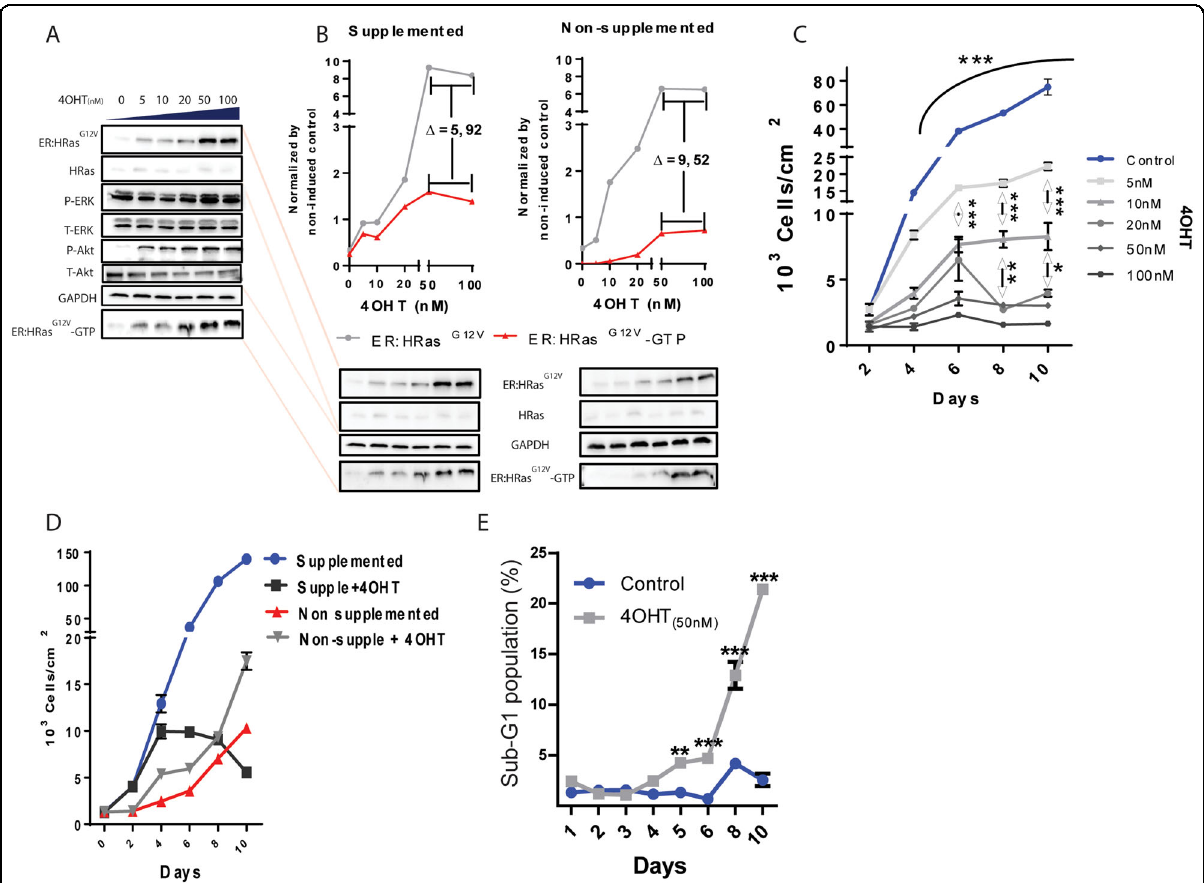
Fig. 1 High HRas G12V activity causes oncogenic stress in the E6E7 keratinocytes grown in supplemented media. A Immunoblots: 4OHT dose – response of ER:HRas G12V induction. The activity of HRas G12V was monitored by a RAS-GTP-binding assay, which leads to downstream activation of P-ERK and P-Akt. B Immunoblots comparing ER:HRas G12V levels between supplemented (5 ng/mL of EGF and 5 µL/mL of pituitary extract) and nonsupplemented media in ER:HRas G12V -keratinocyte cultures. The immunoblot of cells in the supplemented medium is a projection of the one presented in A . The electrophoresis gel of cell lysates derived from cells grown in either supplemented or nonsupplemented media, was blotted in the same membrane to allow comparison of ER:HRas G12V levels and HRas G12V -GTP (HRas G12V -GTP = HRas G12V activity) under both conditions. C Growth curves of ER:HRas G12V keratinocytes in function of 4OHT concentration. The graph is representative of three independent experiments carried out in duplicate. D Effect of 50 nM 4OHT in ER:HRas G12V keratocytes growing in supplemented or nonsupplemented media. The graph is representative of three independent experiments carried out in duplicate. E Evolution of the sub-G1 population of ER:HRas G12V keratocytes growing in complete medium induced or not with 50 nM of 40HT, measured by fl ow cytometry after PI staining. The graph is representative of two independent experiments. For fl ow cytometry, 30 × 10 3 events were considered per condition and time point. Growth curves and the sub-G1 population are presenting data as mean (SD). Two-way ANOVA *P ≤ 0.05, ** P ≤ 0.01, and *** P ≤ 0.001, Bonferroni post